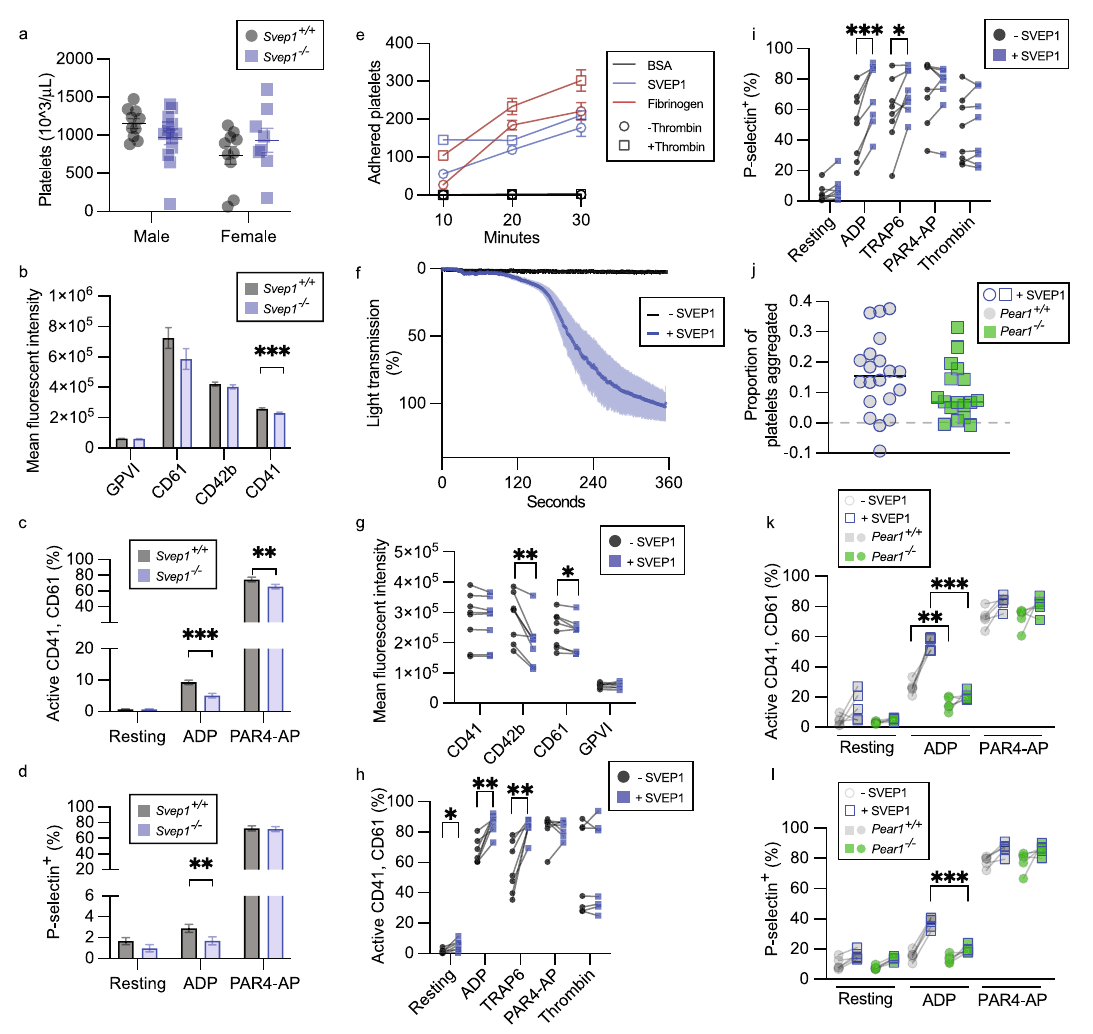
Fig. 5 | SVEP1 activates platelets. a Platelet counts in whole blood from Svep1 +/+ and Svep1 -/- mice. Data are presented as mean values±SEM. b Platelet receptor density in whole blood from Svep1 +/+ and Svep1 -/- mice. Bars represent least square means and error bars represent the standard error of difference ( b – d